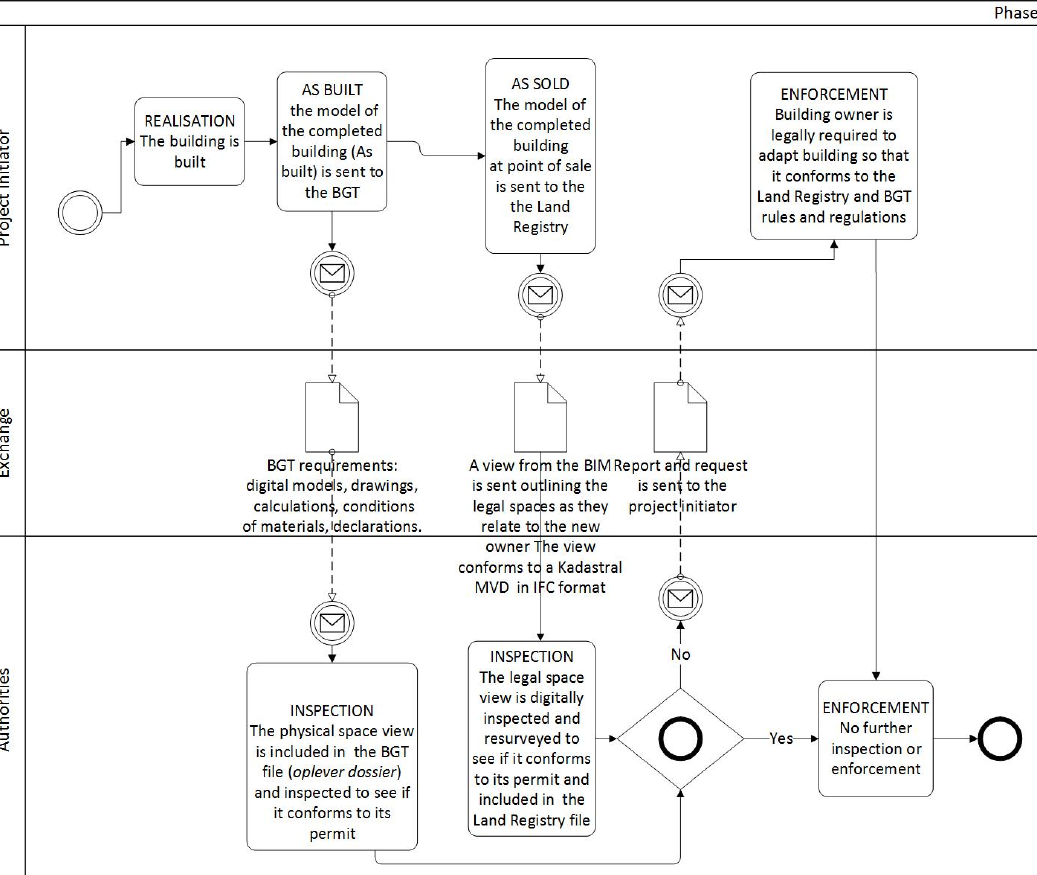
Figure 3 . IDM Workflow: Cadastral Registration by means of a 3D BIM Phase2. Figure 3. IDM Workflow: Cadastral Registration by means of a 3D BIM Phase